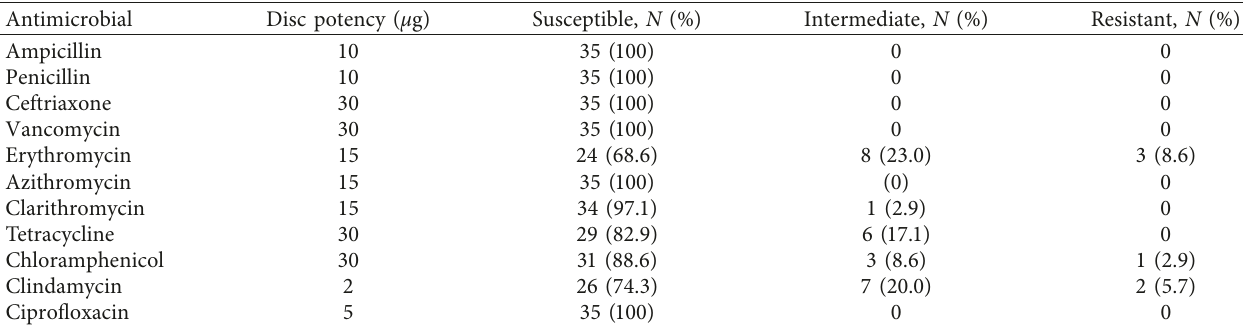
Table 5: Antimicrobial susceptibility patterns of GBS isolates from pregnant mothers and neonates. Antimicrobial Disc potency ( μ